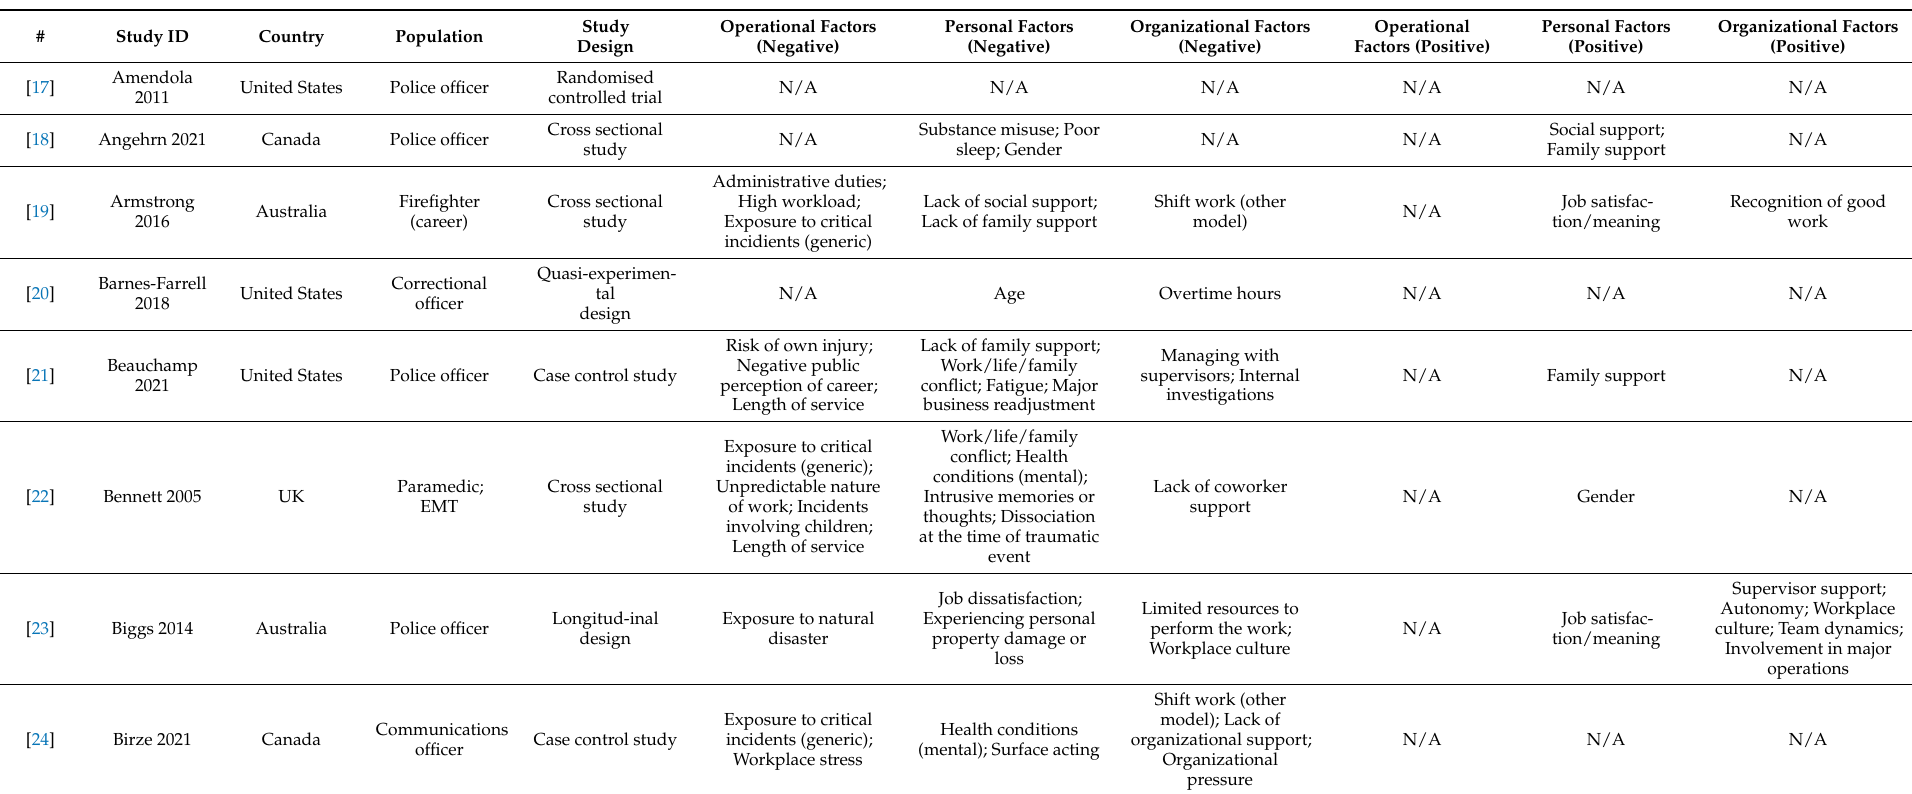
Table 1. Study Characteristics and